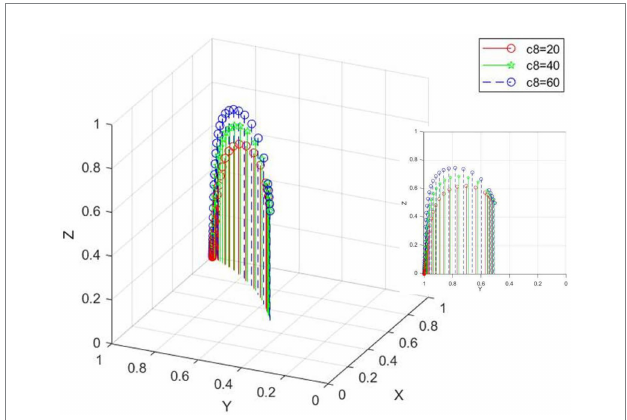
FIGURE 13 Impact map of government failure costs (Scenario 1).